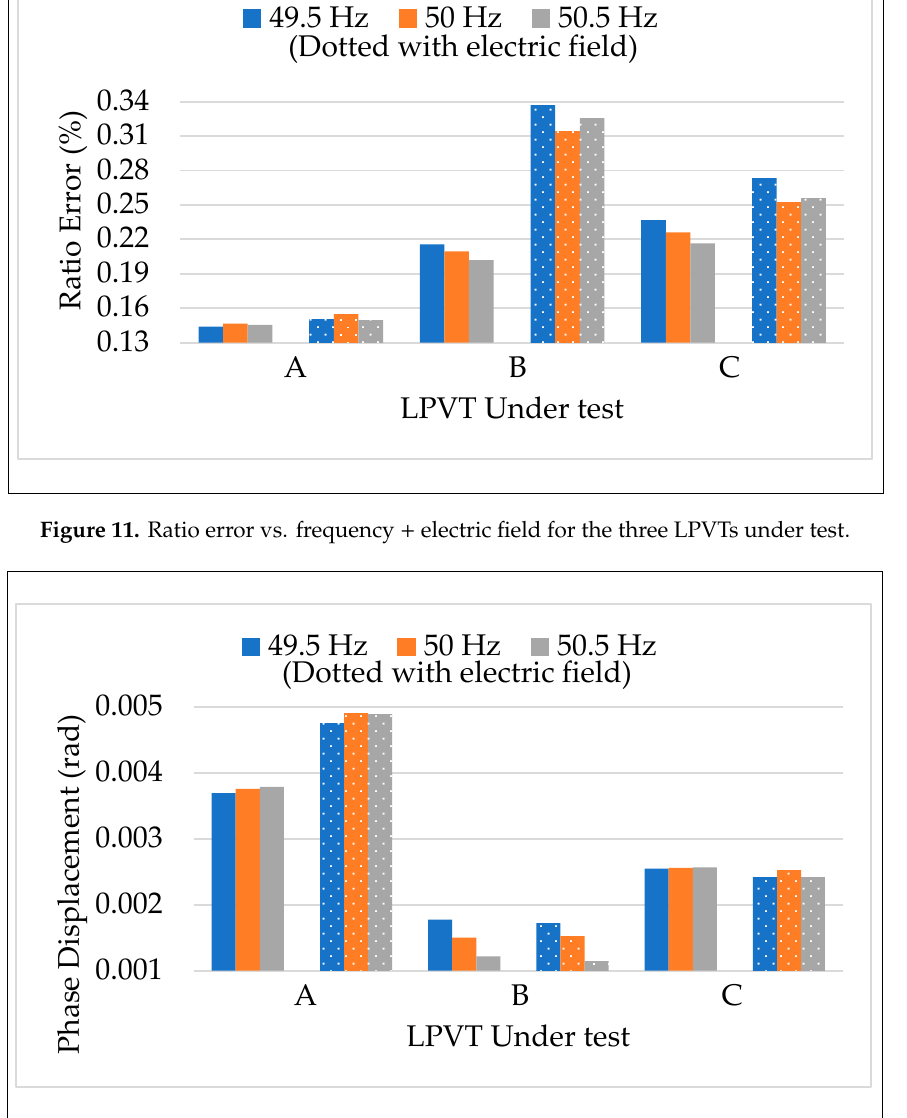
Figure 12. Phase displacement vs frequency + electric field for the three LPVTs under test.